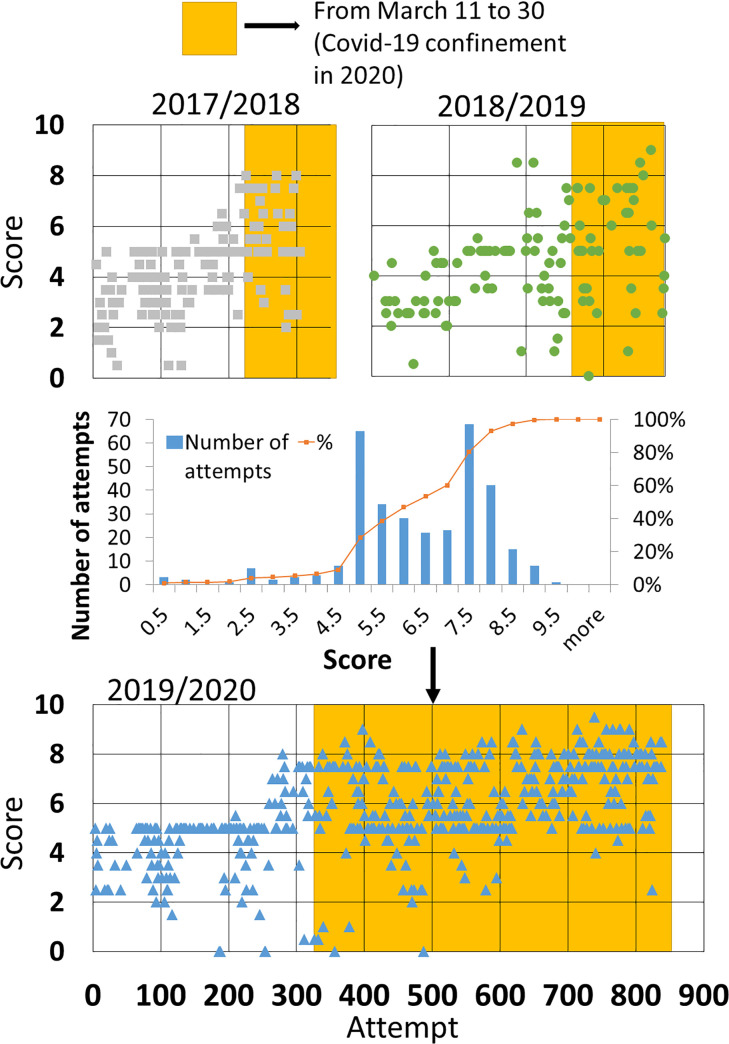
Attempts vs. scores ordered chronologically for the three academic years under study in “Applied Computing”.